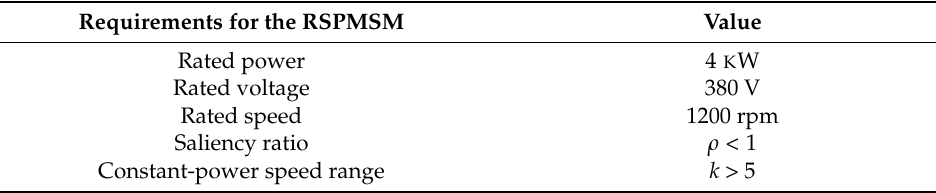
Table 1. The requirement indices for the RSPMSM.